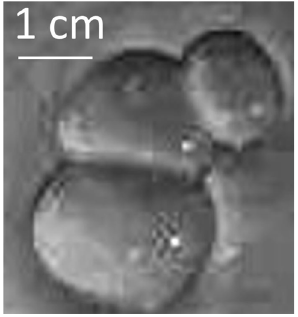
Fig. 9. Coalescence.